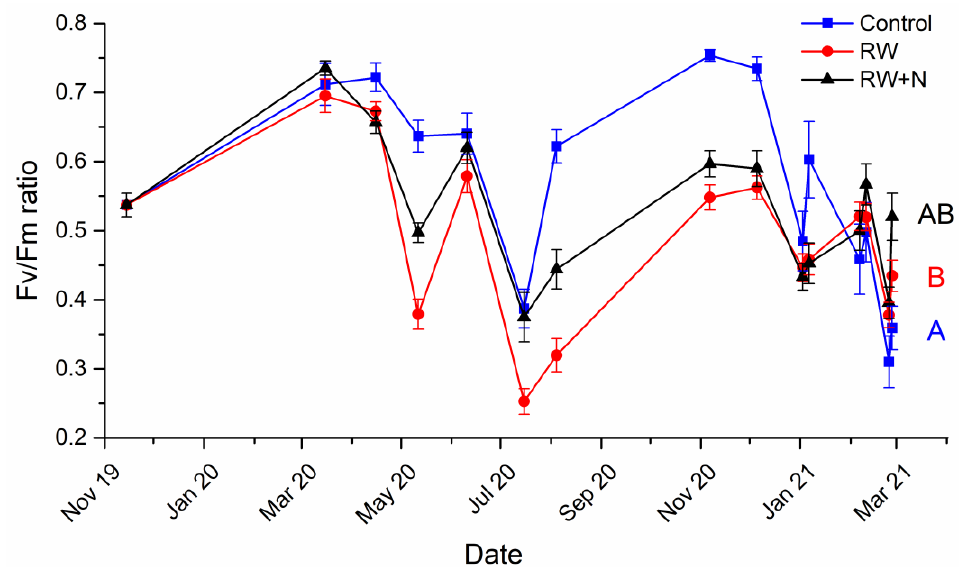
Figure 2. Temporal evolution of Fv/Fm ratio during phase 1 of the experiment for Control (watered every day, blue squares), RW (watered twice per week, red dots) and RW+N (watered twice per week with 40 kg N h − 1 year − 1 , black triangles) samples. Uppercase letters indicate significant differences among treatments. The study was conducted from November 2019 to March 2021.